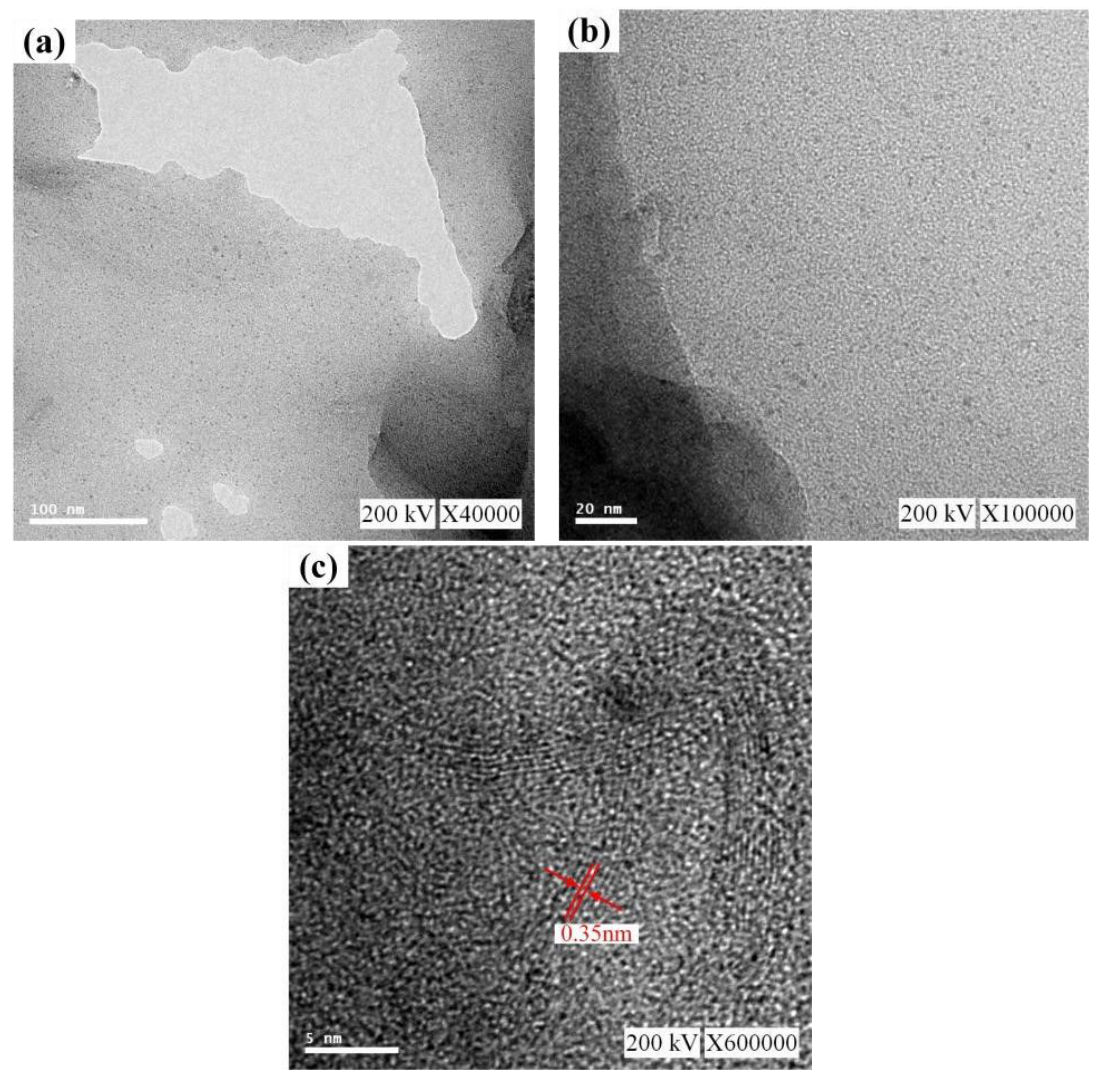
Figure 9: TEM images of the graphene scale bar: (a) 100; (b) 20; (c) 5